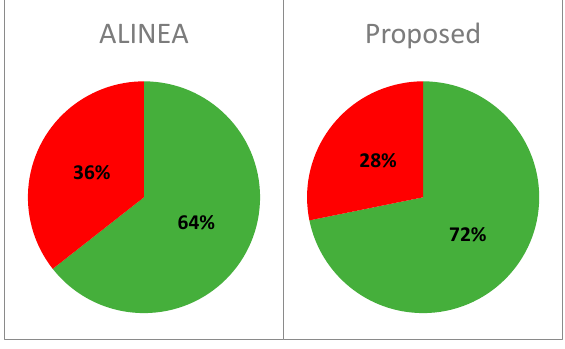
Figure 19. Ramp signal green and red state comparison.